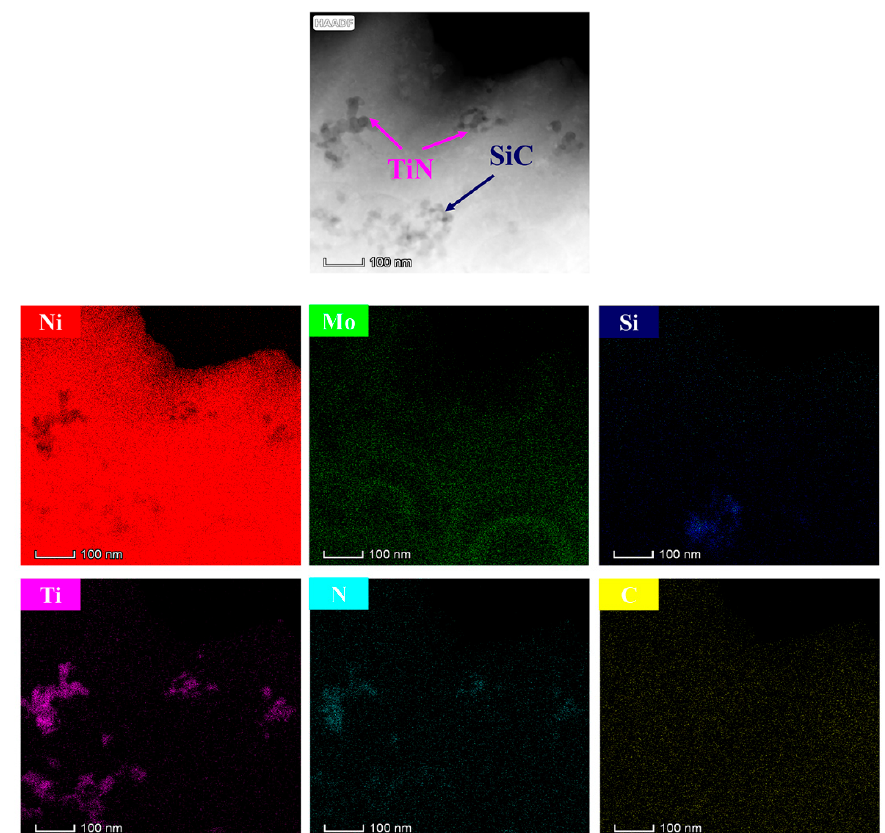
Figure 4. EDS (energy dispersive spectrometer) element mapping of the Ni–Mo–SiC–TiN nanocomposite coating.